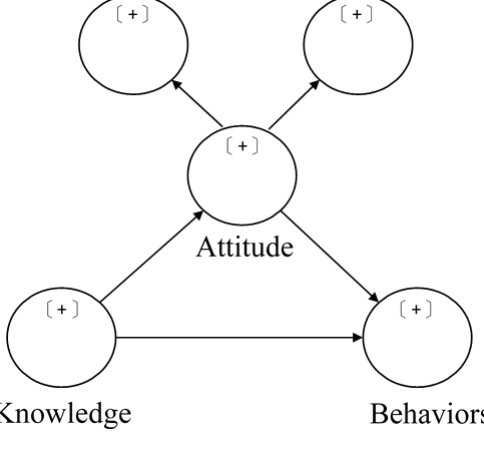
Figure 1. Research framework.